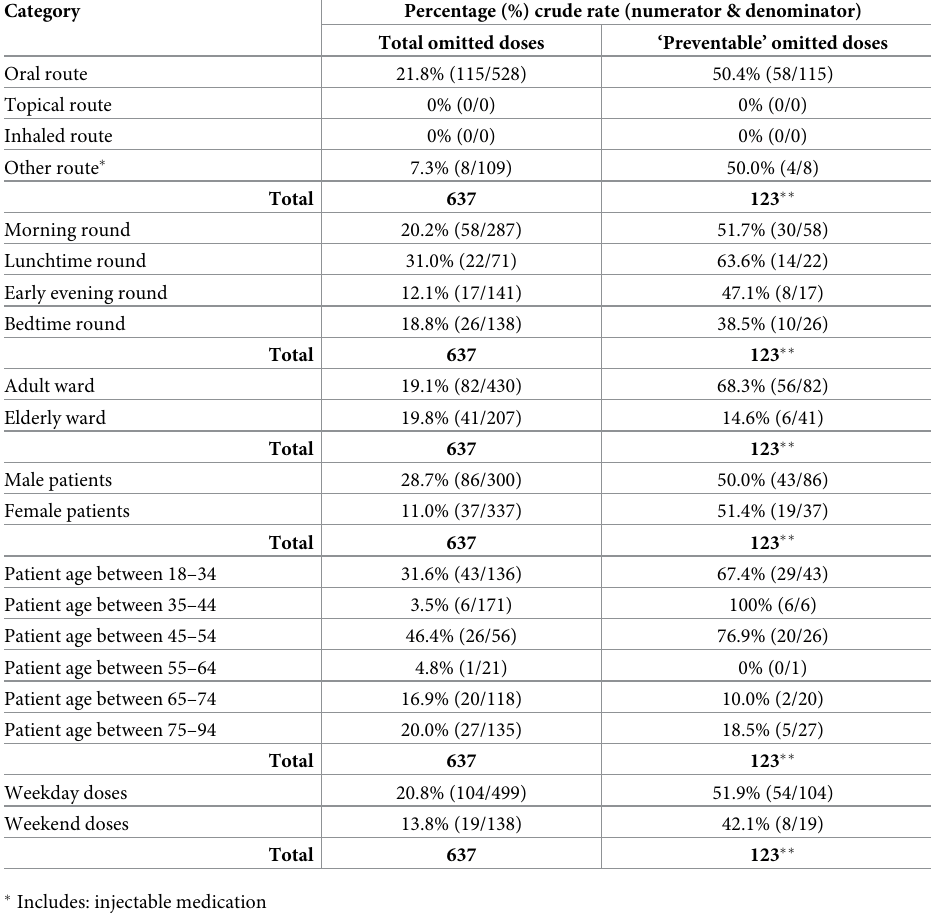
week, patient age, patient gender and ‘time critical’ medications were not taken forward to multi-variate analysis. Details of the predictor analysis for total omitted doses are presented in Table 4. Multivariate analysis–‘preventable’ omitted doses. Compared with ‘non-preventable’ omissions, ‘preventable’ omitted doses were reported to be twice as likely to occur with ‘time critical’ doses than ‘non-time critical’ doses (OR 2.24 (1.22–4.11), p = 0.01). ‘Preventable’ dose omissions were 46% more likely to occur than ‘non-preventable’ omissions for the early even- ing medication round (OR 1.46 (1.01–2.12), p < 0.001, compared to morning) and were 37% Table 2. Crude rate of ‘time critical’ medication omissions across